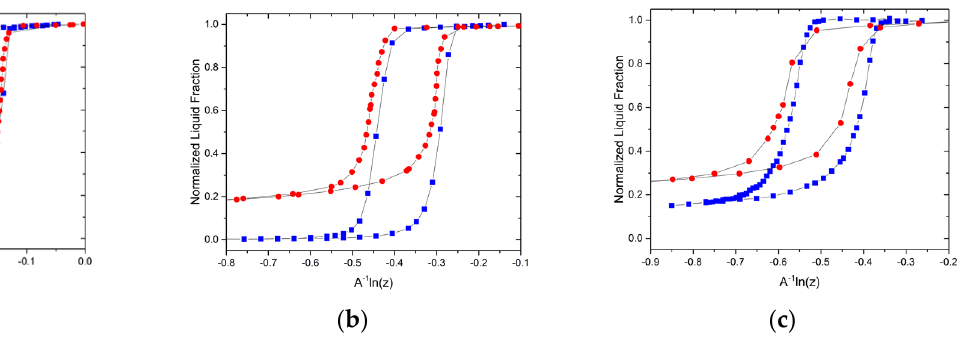
Figure 1. Comparison of nitrogen sorption isotherms (red circles) and freezing/melting transitions for water (blue squares) in ( a ) controlled porous glass of mean pore size ≈ 12.8 nm; ( b ) controlled porous glass of mean pore size ≈ 10.5 nm and ( c ) SBA-15 of mean pore size ≈ 8 nm. Figure ( c ) has been reproduced with permission from ACS Publications [27].